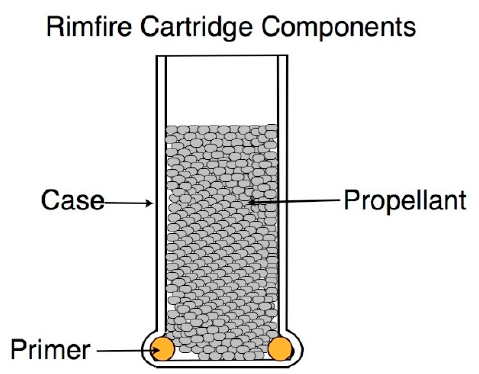
Figure 1. Rimfire cartridge components. Cross sectional diagram of an uncrimped blank cartridge.